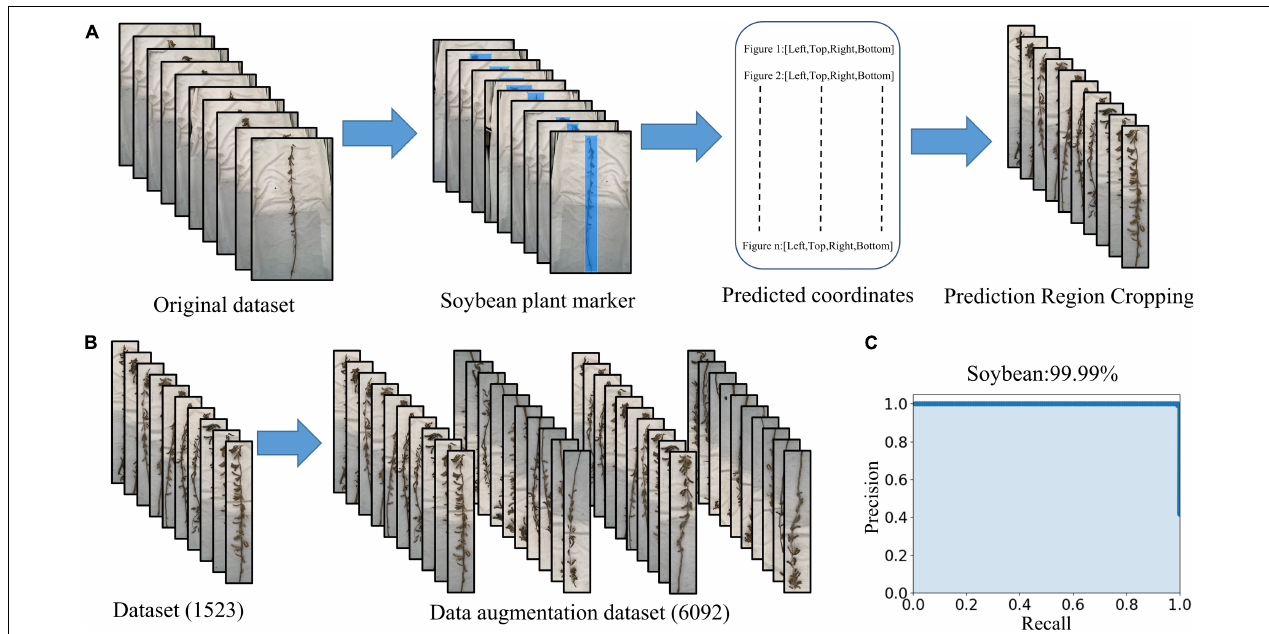
FIGURE 3 | Image preprocessing process: (A) remove excess background and keep the smallest bounding rectangle of soybean plants, (B) data augmentation, and (C) precision–recall curve of soybean plant recognition